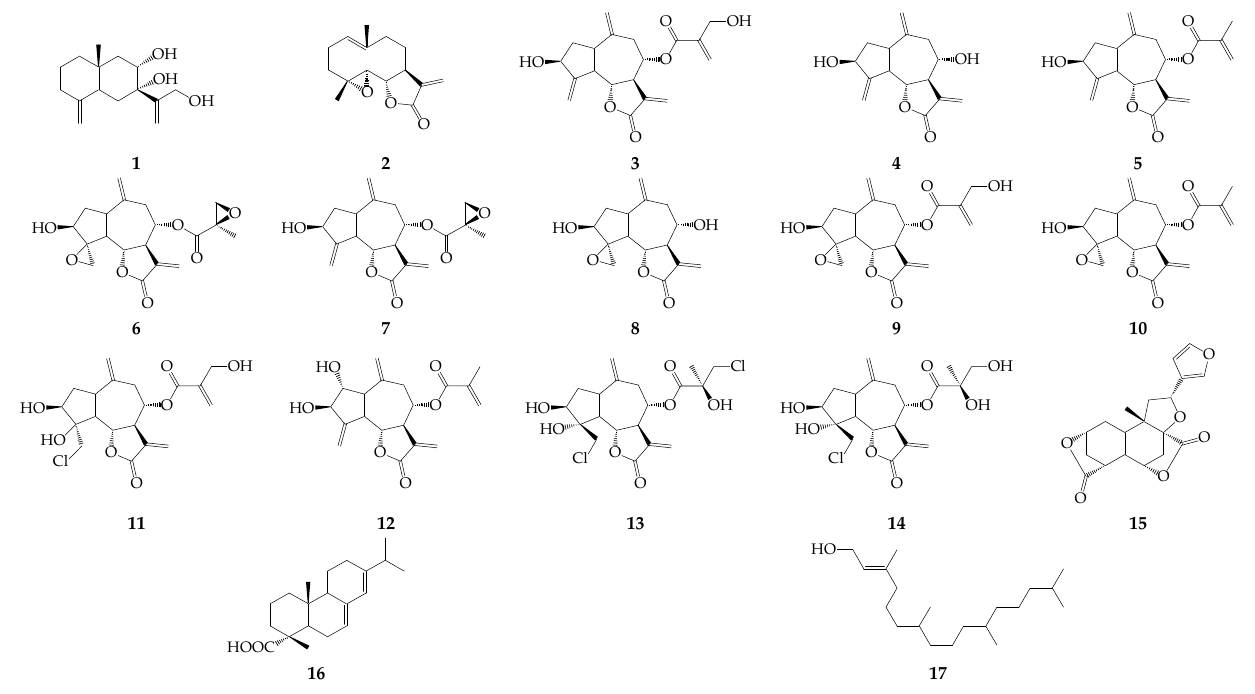
Figure 2 . Sesquiterpenes 1 – 14 and diterpenes 15 – 17 . Figure 2. Sesquiterpenes 1 – 14 and diterpenes 15 – 17 . Table 2. Compounds 1 – 225 found in R. uniflorum